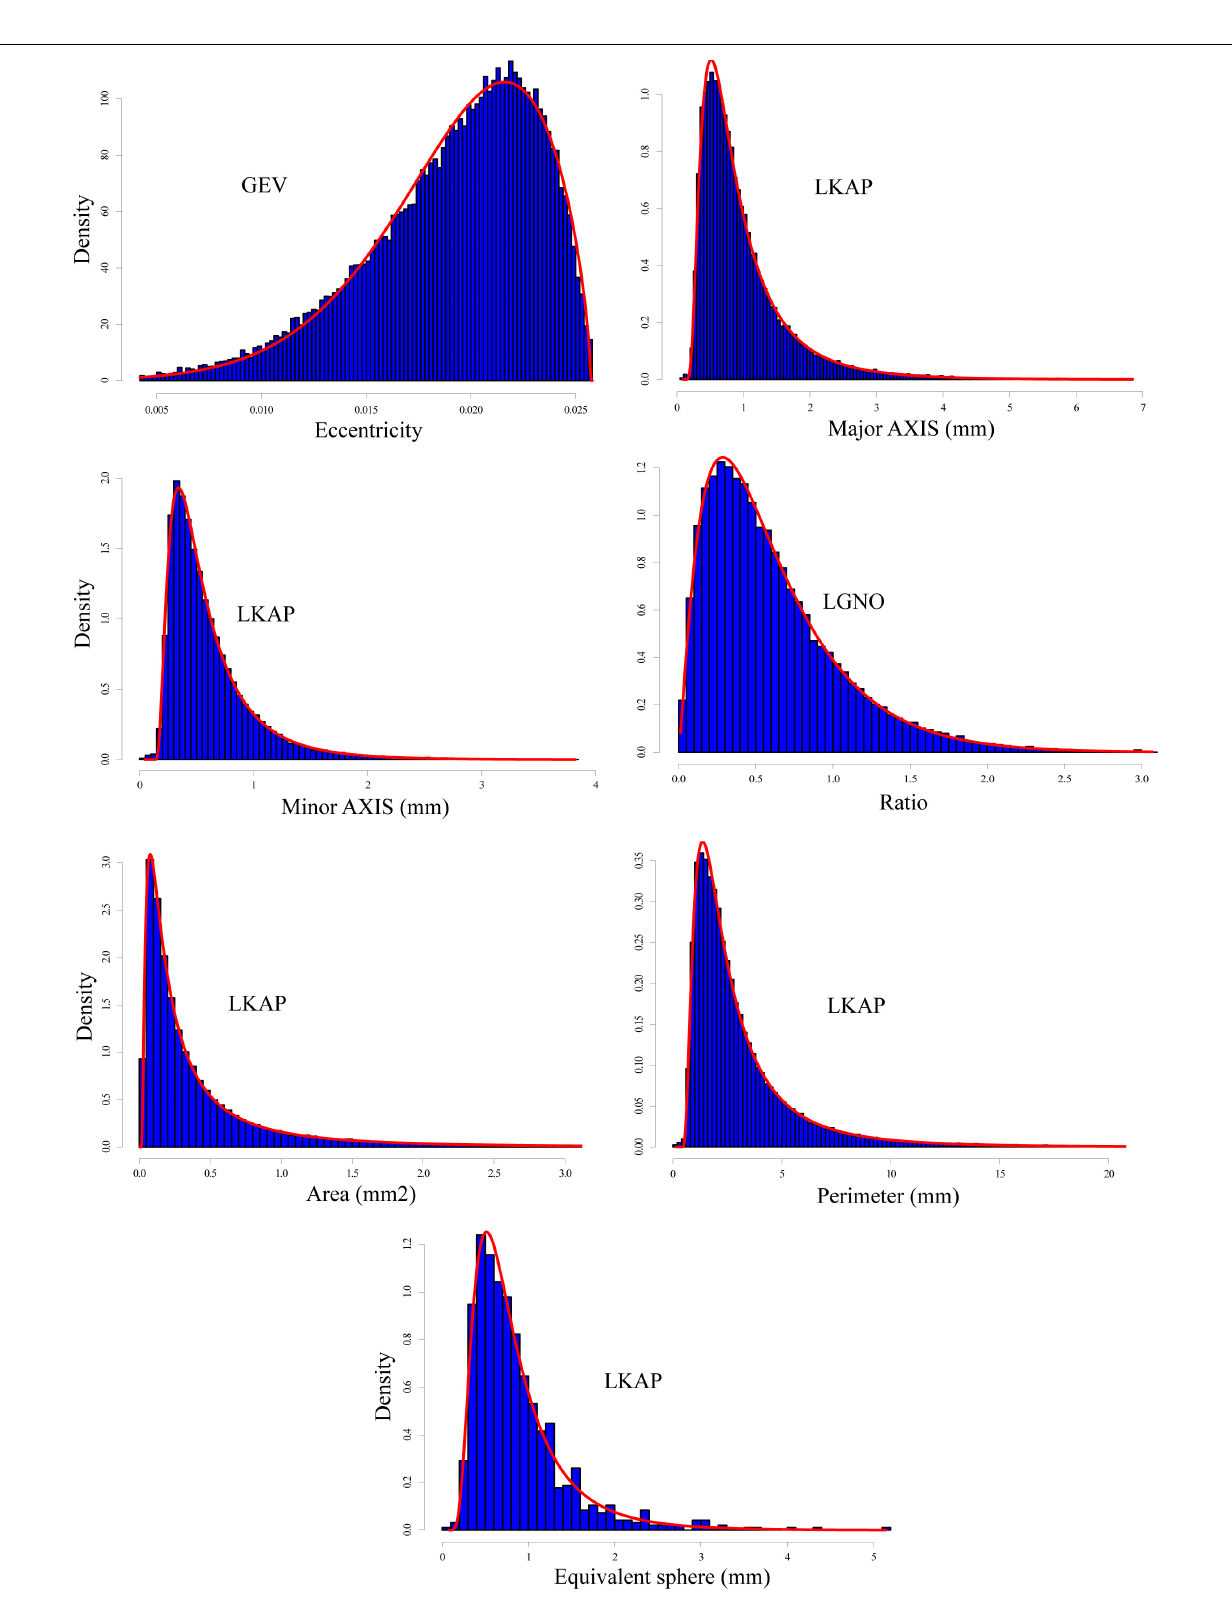
Frontiers in Earth Science |